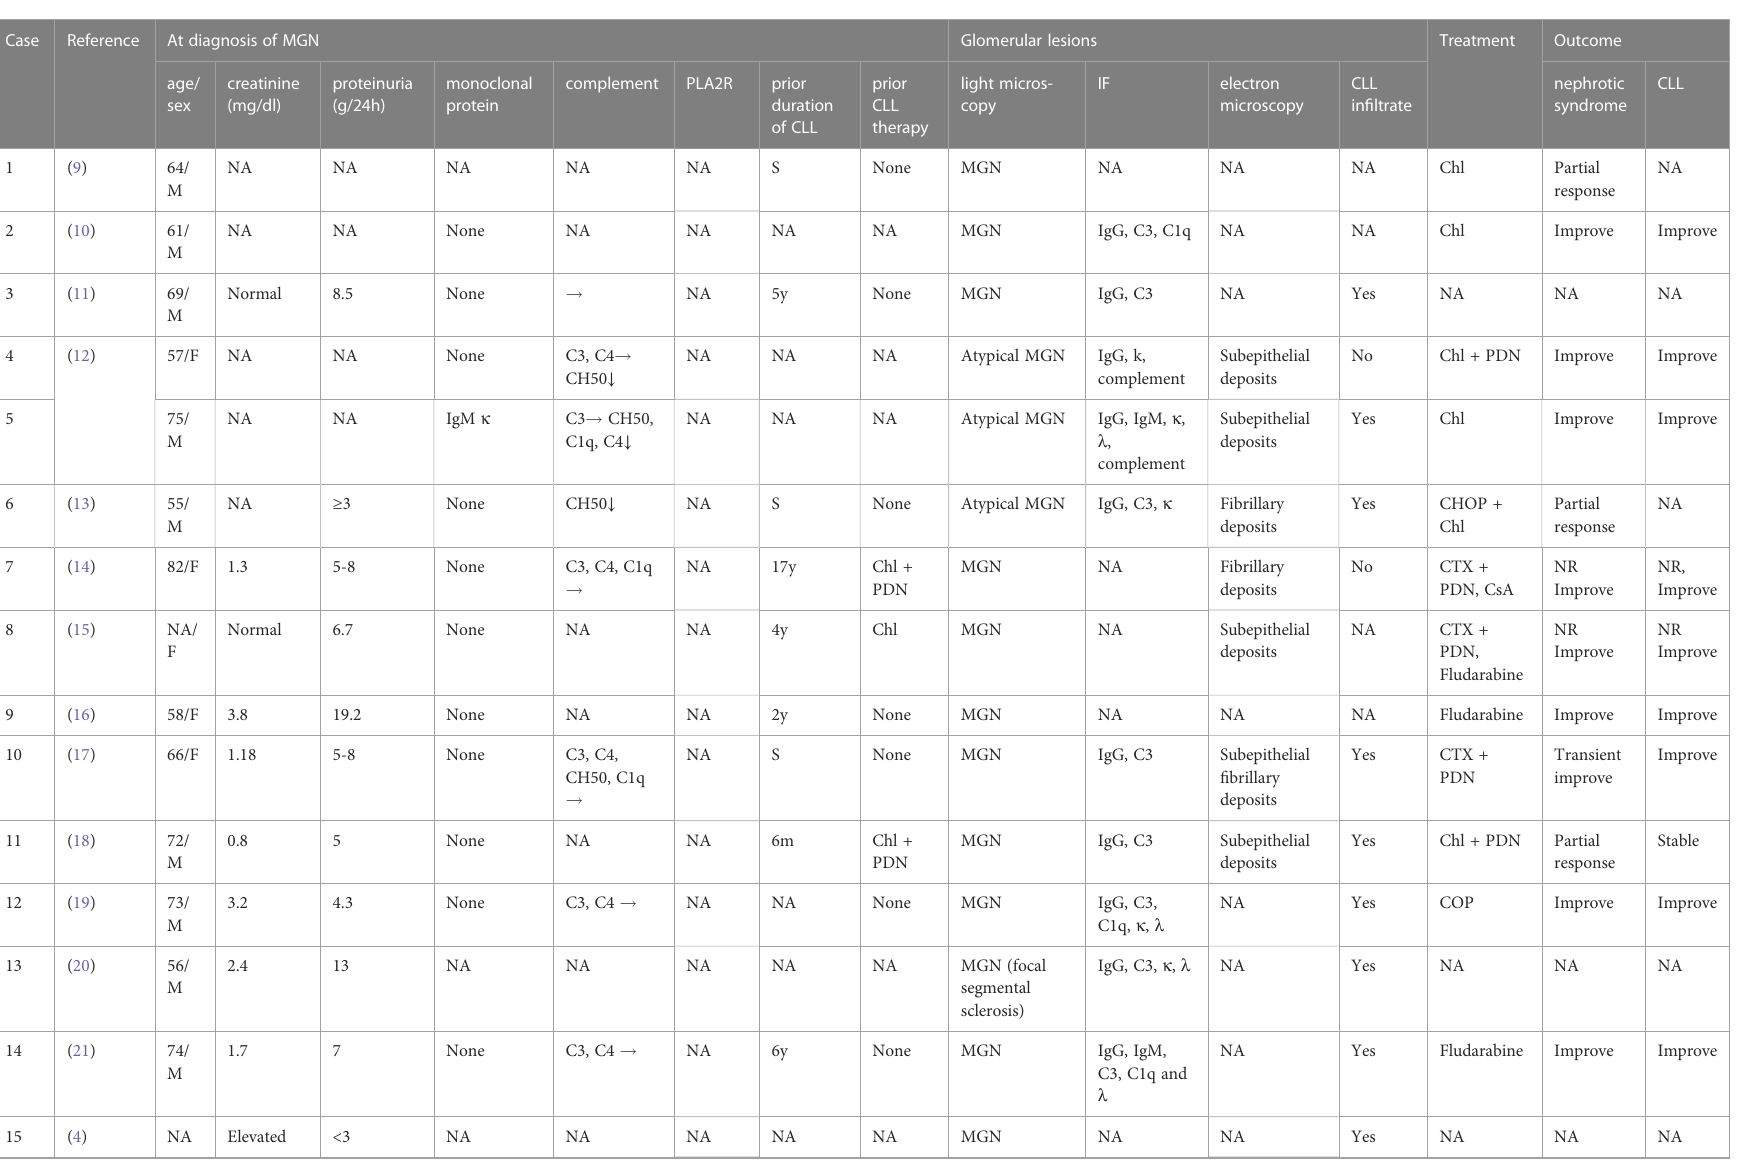
TABLE 1 CLL-related MGN cases reported in the literature to